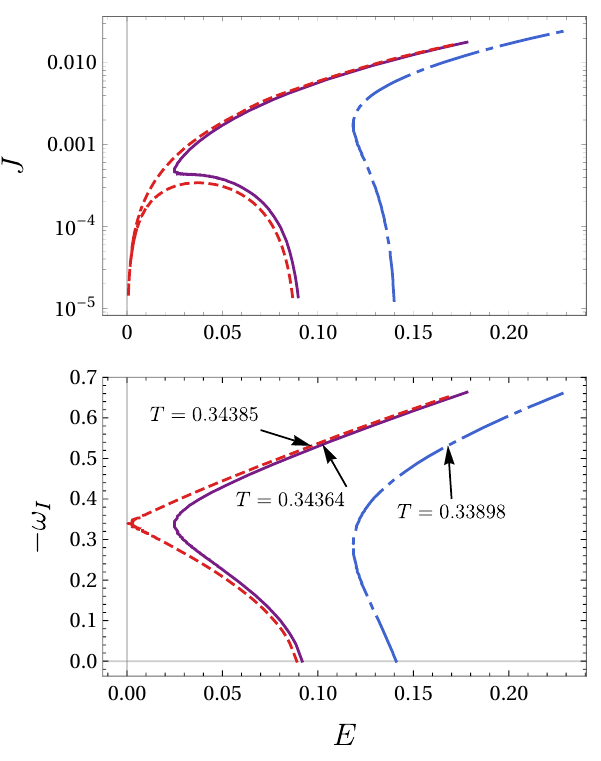
Figure 3 . (Top) E dependence of J , (bottom) − ω I as a function of E at various